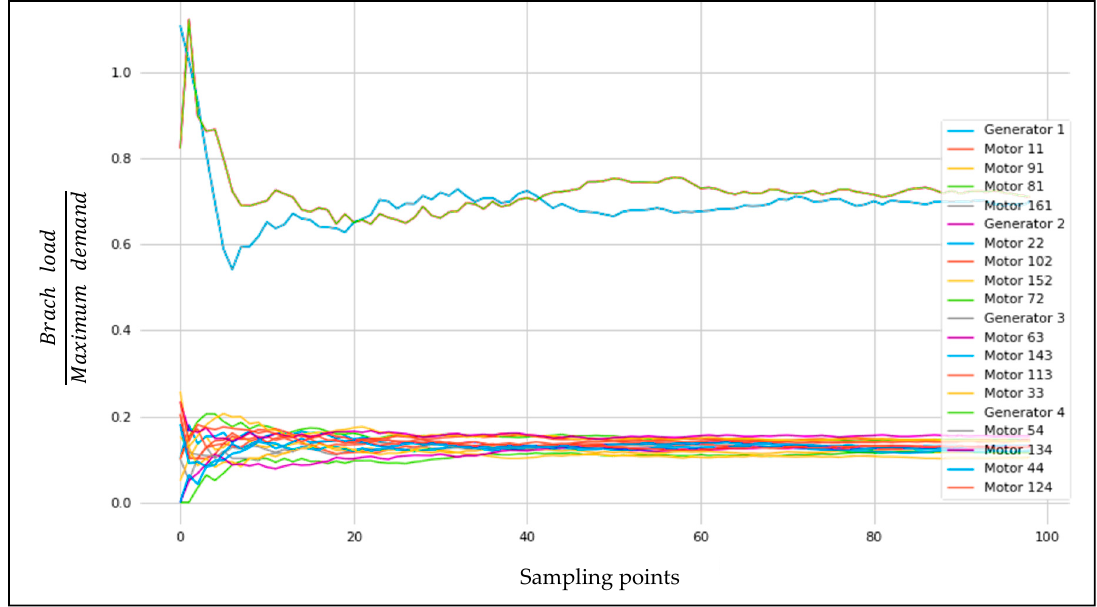
Figure 10. Monte Carlo TO NASA N3-X branch loading average.